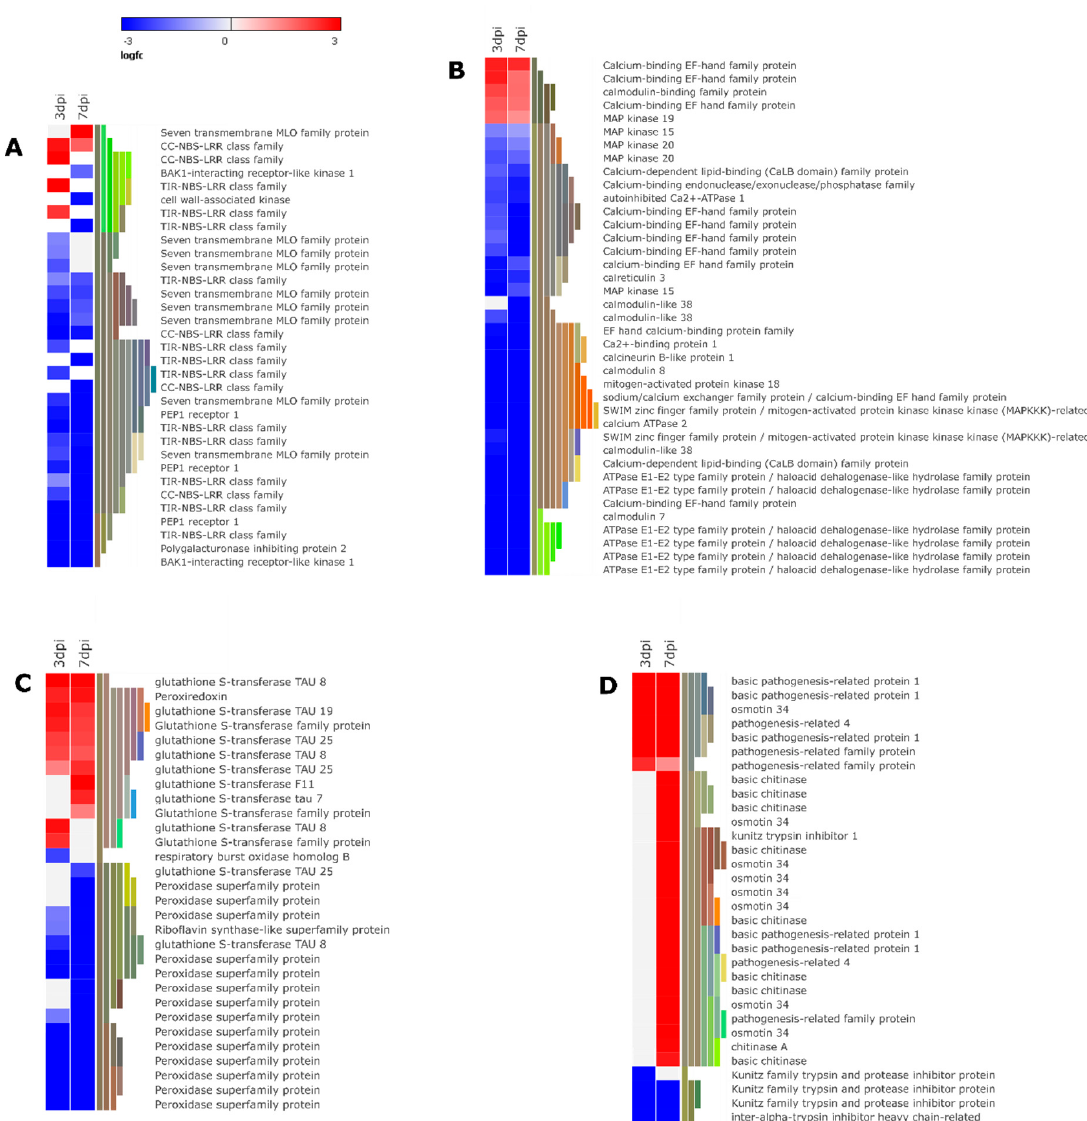
Figure 5. Heat map representation of selected di ff erentially expressed genes associated with pathogen perception ( A ). Mitogen-activated protein kinase (MAPK) signaling pathways and calcium signaling pathways ( B ). Oxidative stress ( C ). Pathogenesis-related proteins and proteinase inhibitors ( D ). (The heat map illustrates a subset of genes from each group. Refer supporting information for all di ff erentially expressed genes in each group).